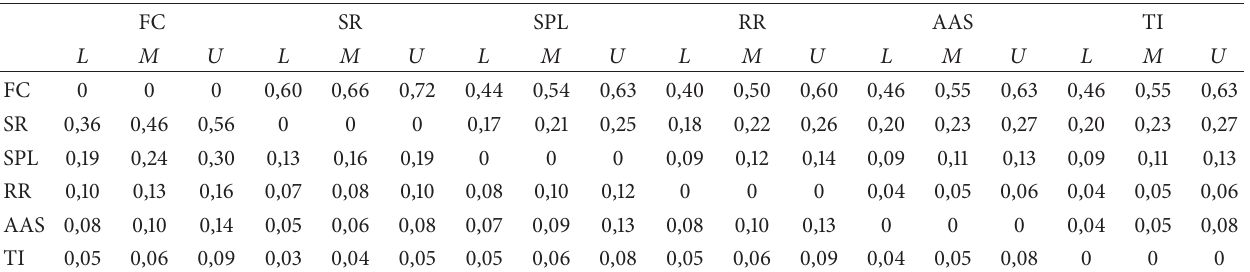
Table 7: Pairwise comparison for 𝑊 22 .